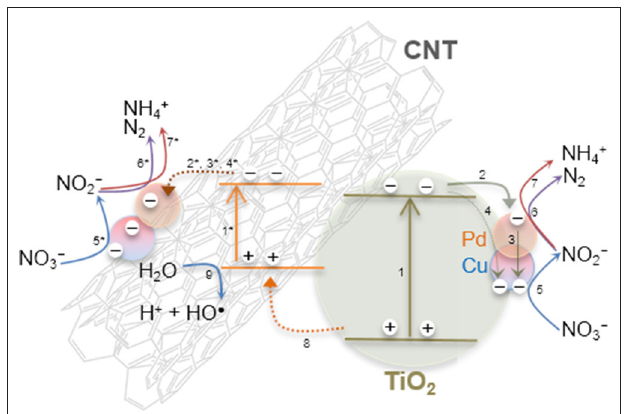
FIGURE 9 | Schematic representation of the photocatalytic reduction of nitrate over Pd–Cu/CNT-TiO 2 catalysts in the presence of H 2 and CO 2 , under near UV to visible light